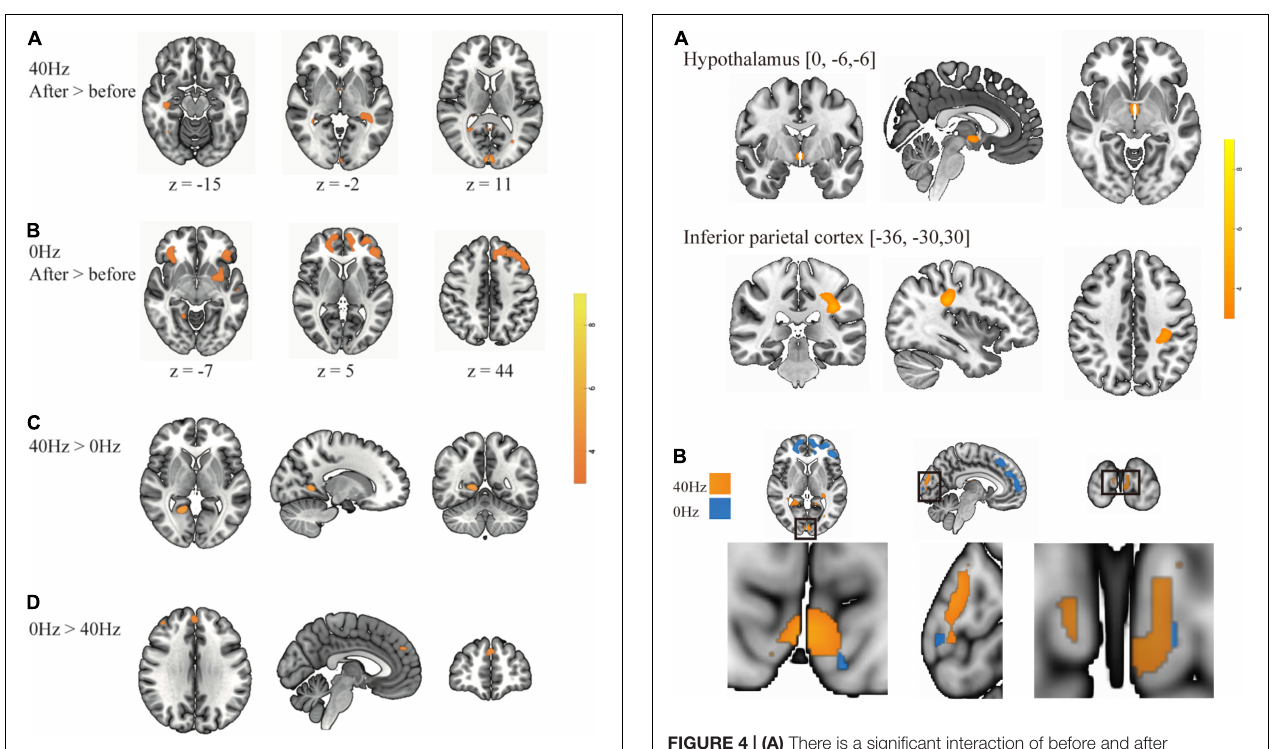
FIGURE 3 | Greater brain activation is associated with comparisons between before and after optical stimulation in each group: (A) The 40-Hz group shows additional activation in the bilateral hippocampus and visual cortex. (B) The 0-Hz group shows increased activation in the prefrontal cortex. For a direct comparison between two groups: (C) The 40-Hz group shows greater activation in the left para-hippocampus and (D) The 0-Hz group shows greater activation in the middle frontal cortex and medial frontal cortex.